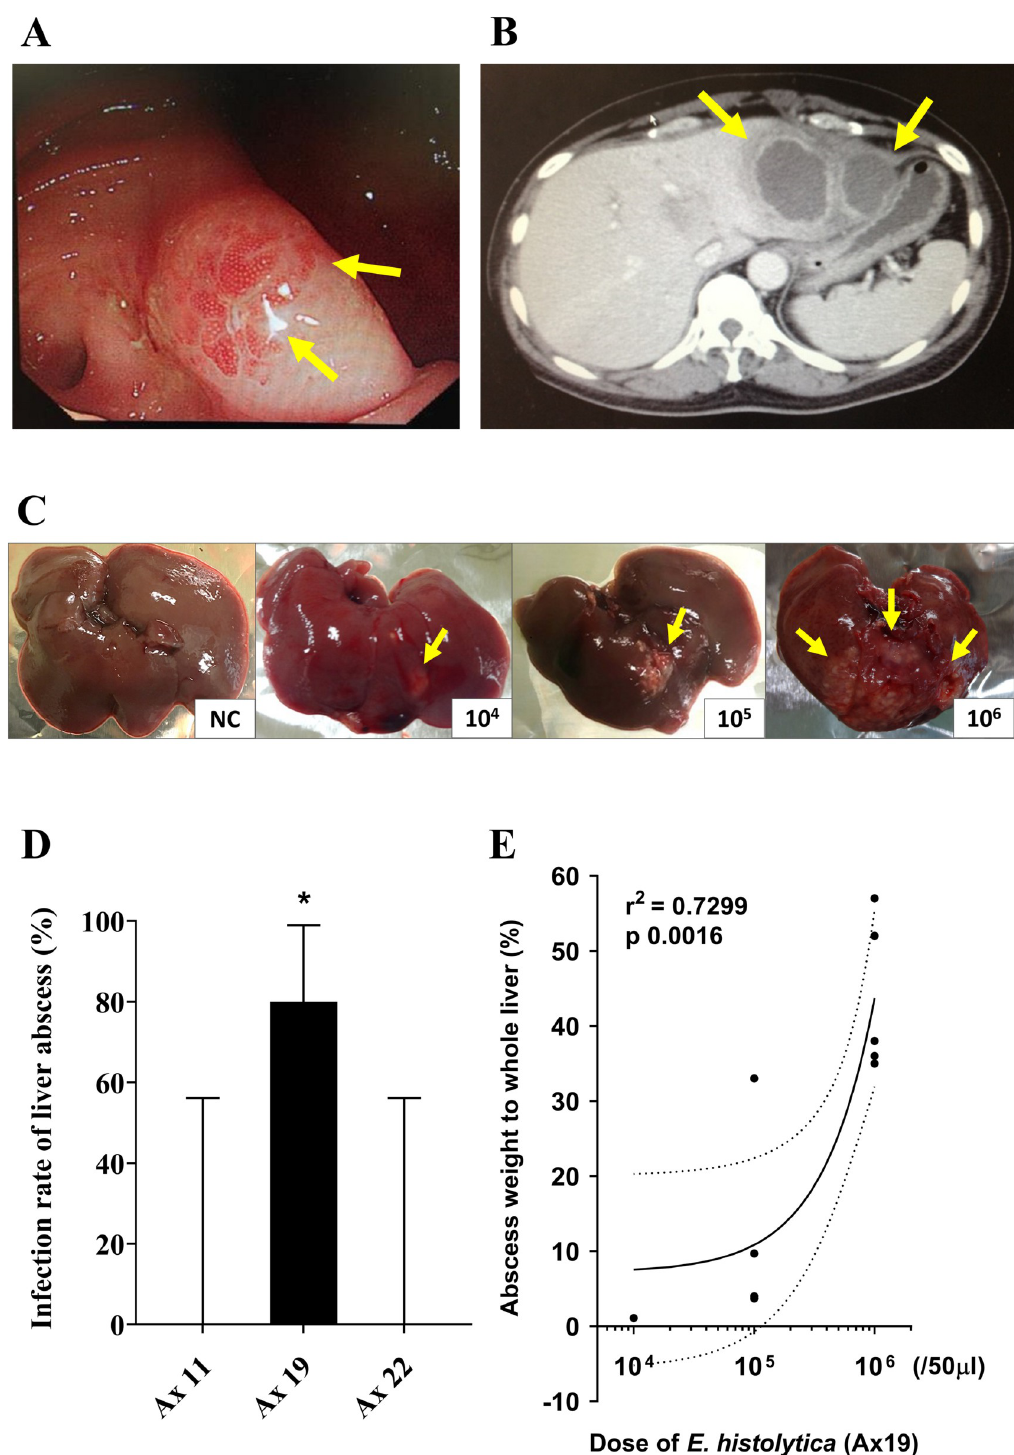
Fig 1. Comparison of the virulence potential of isolated E . histolytica clinical strains using an animal model. (A) Colonoscopy image of asymptomatic chronic infection. Multiple erosions localized in the cecum were identified (yellow arrows). (B) CT finding of multiple amebic liver abscesses (yellow arrows). E . histolytica clinical strain Ax19 was isolated from the aspirated pus from the abscess. (C) Experimental amebic liver abscess produced by injection of a highly virulent strain (Ax19) into Syrian hamsters. The size of the liver abscess increased according to the injected dose of Ax19. NC, negative